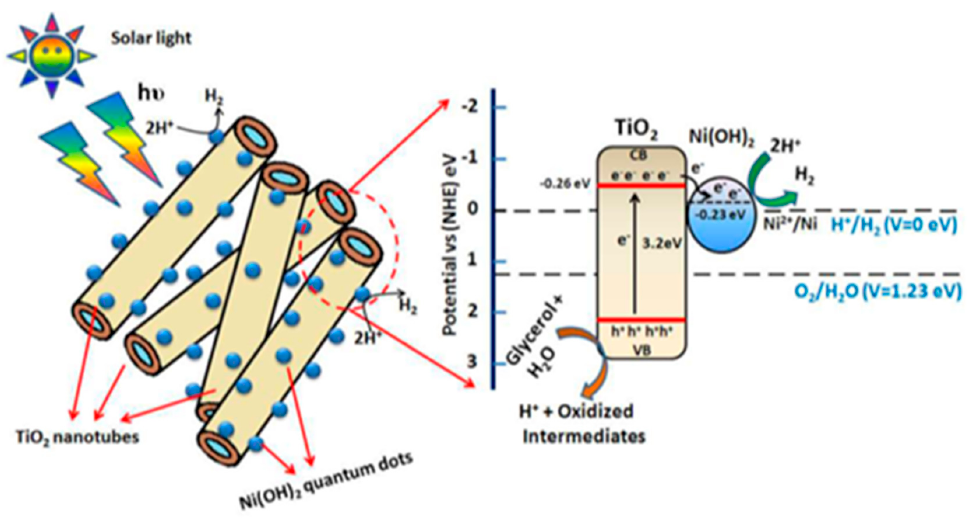
Figure 4. The mechanism for H 2 evolution on Ni(OH) 2 /TiO 2 nanotubes [28]. Reprinted with permission from ref. [28]. Copyright 2020 American Chemical